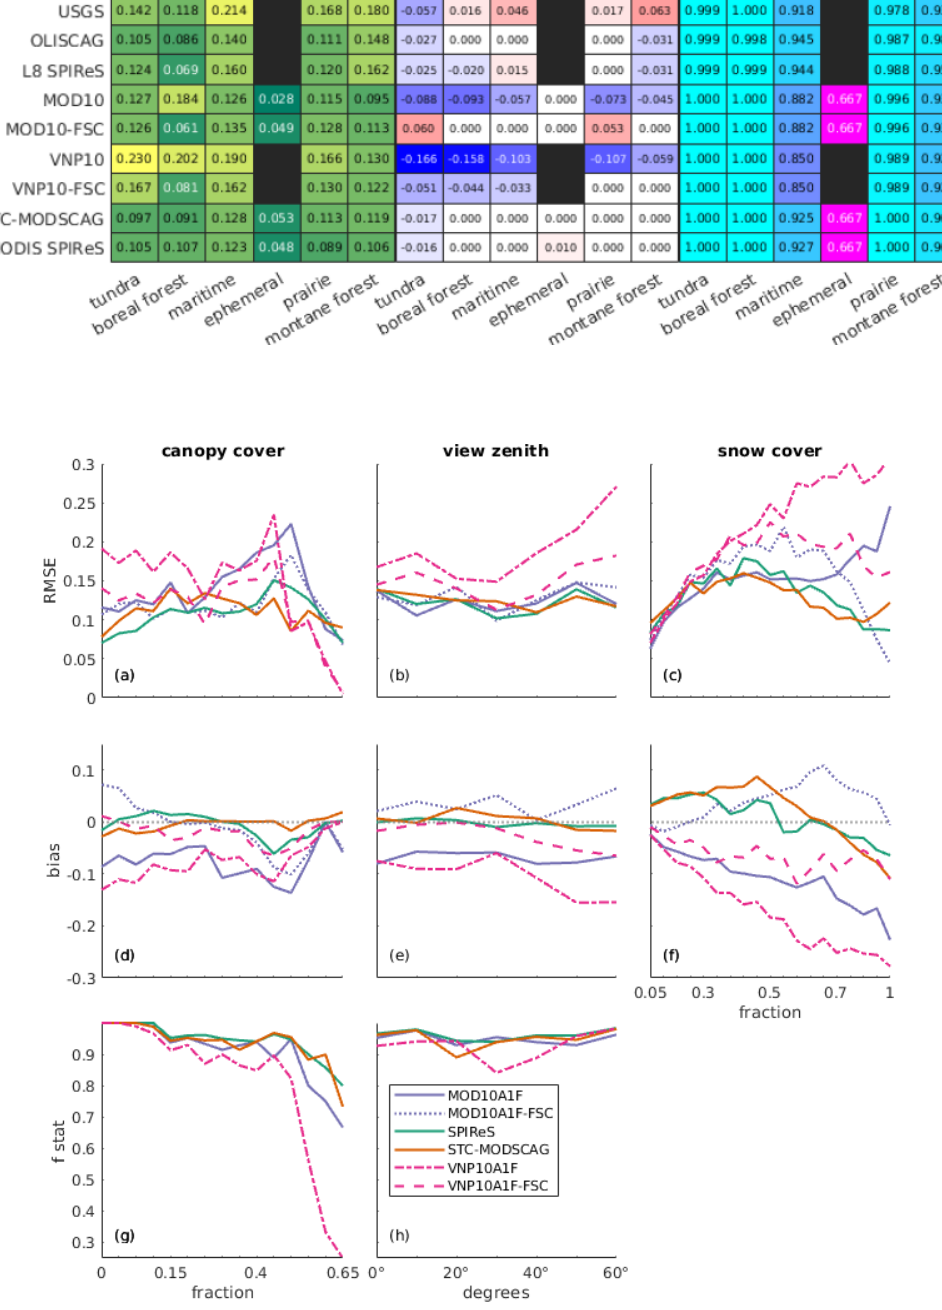
Figure 5. Snow cover mapping statistics: RMSE (a–c) , bias (d–f) , and F -statistic (g, h) values calculated for pixels binned by canopy cover fraction (a, d, g) , view angle (b, e, h) , and snow cover fraction (c, f) using the MODIS and VIIRS snow cover products. The standard products (MOD10 and VNP10) are colored so that each standard product is shown as a solid line, while the fSCA correction is shown in the same color with a dashed line (the F statistic is unchanged by the correction process). No F -statistic graph is displayed for the snow cover fraction due to the low variability in the F statistic induced by the snow cover